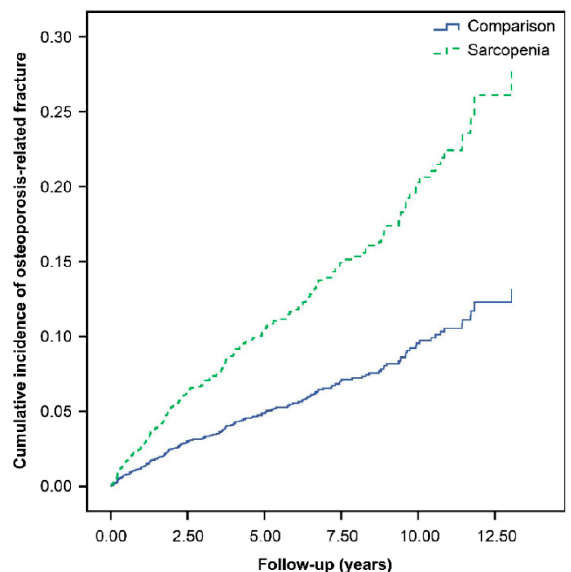
Figure 2. Plots of the log [ − log (survival function)] versus the log of survival time for the comparison cohort and sarcopenia cohort.